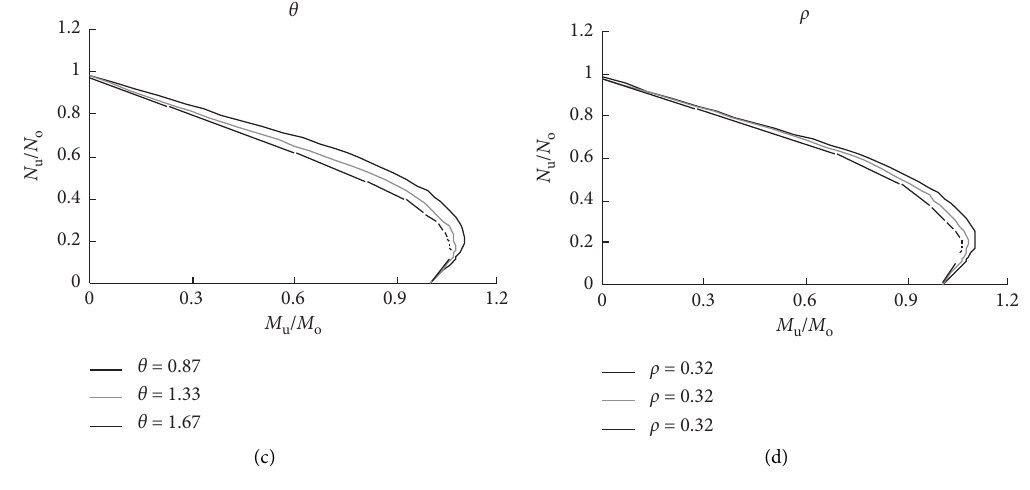
Figure 11: Influence of parameters on N